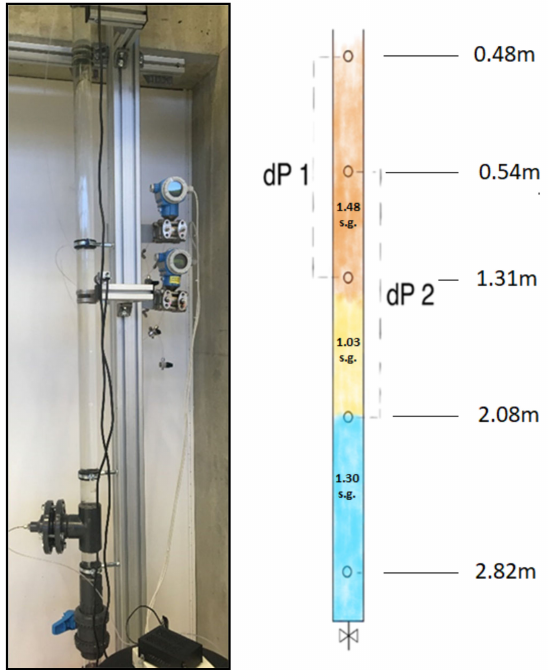
Figure 7. Laboratory experimental equipment. Picture of the tiltable tube to the left, and the experimental design drawing to the right. The position measurements refer to distance from the